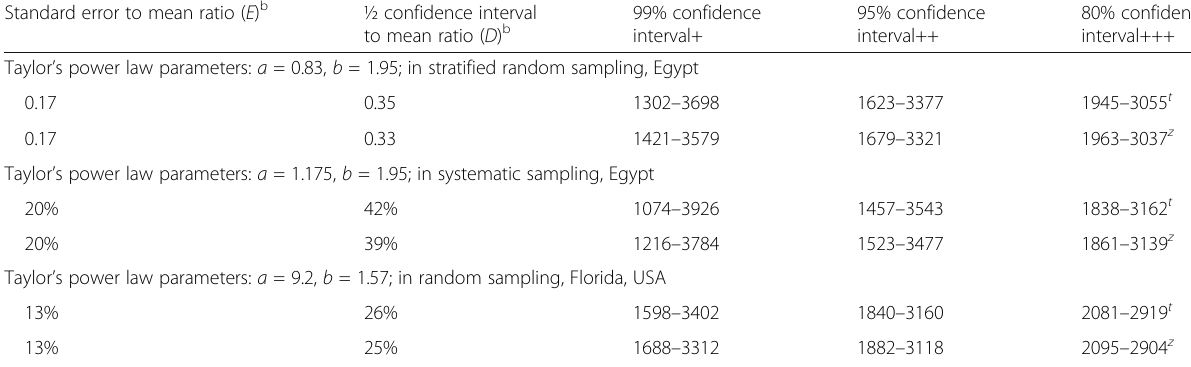
Table 1 Precision estimates for Tylenchulus semipenetrans population densities based on data derived from citrus orchards a Standard error to mean ratio ( E ) b